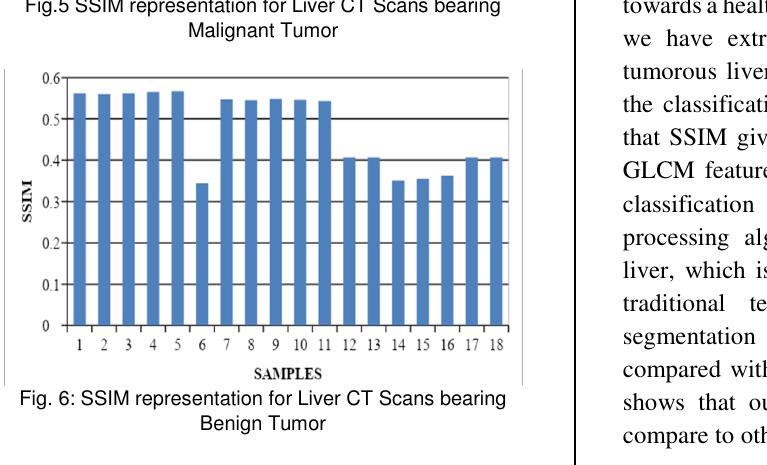
Fig. 6: SSIM representation for Liver CT Scans bearing Benign Tumor